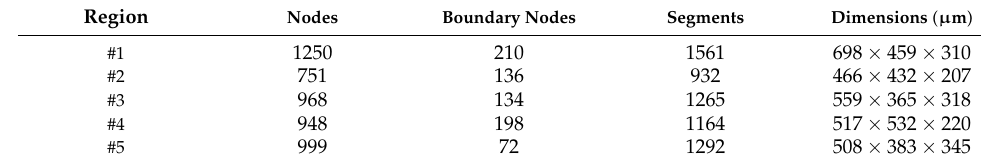
Table 1. Morphological properties of the 5 considered cortical regions.